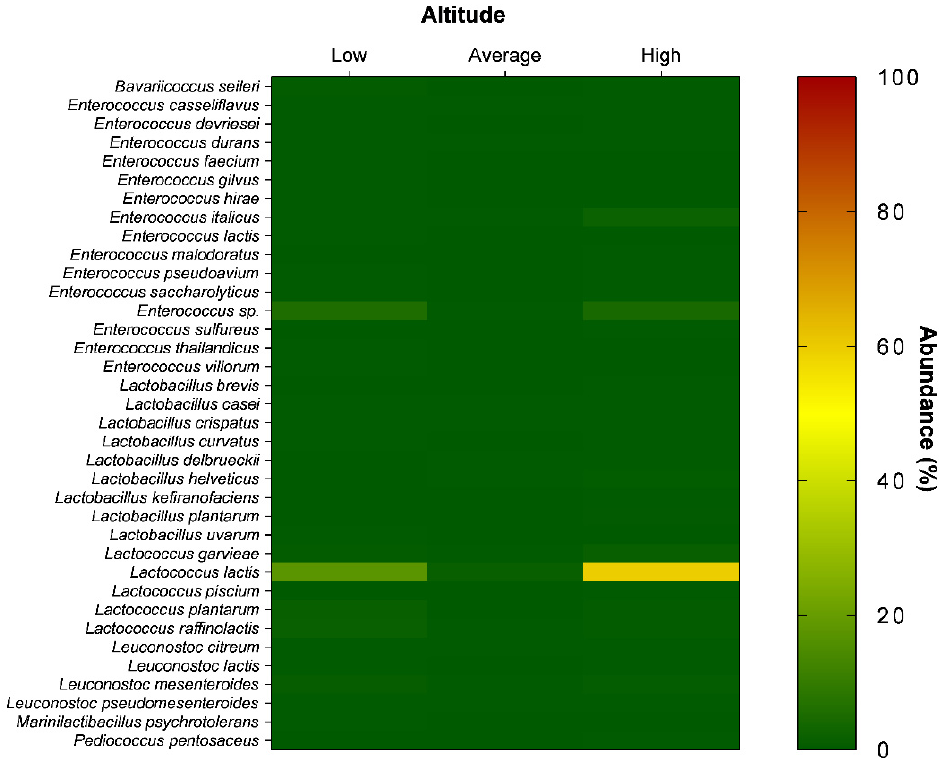
Figure 6. The abundance of species from different altitudes. The classification of altitude into low (up to 150 m), medium (>150 and <350 m), and high (>350 m) was based on the average altitude of the state of Rio Grande do Sul State (206 m). Source: https://pt-br.topographic-map.com/map-pb651/Rio-Grande-do-Sul/, accessed on 14 October 2022.